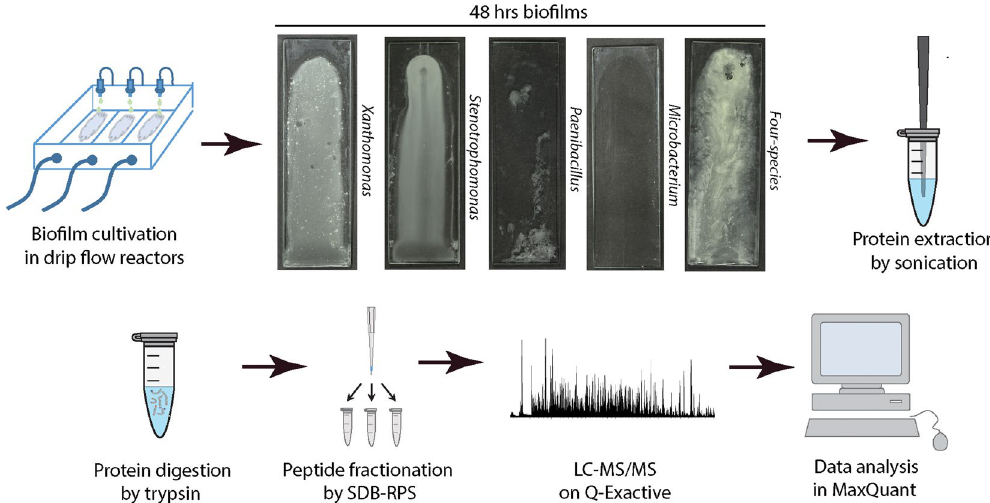
Figure 1. Overview of experimental design. Biofilm was cultivated in a drip flow reactor for 48 hrs and single and four-species biofilm was scraped off the glass slide. Proteins were extracted sonication, digested with trypsin and the resulting peptides were separated into three fractions using SDB-RPS filter tips. Mass spectrometric analysis was performed on a Q-Exactive and data was analyzed using MaxQuant with label free